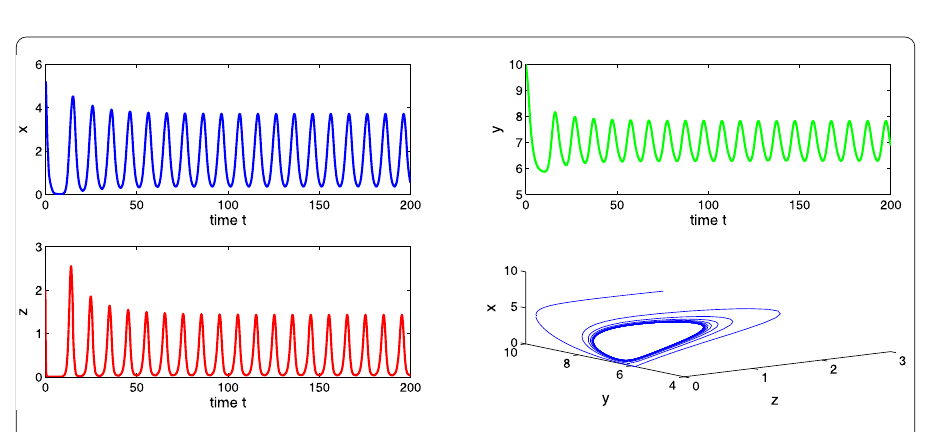
Figure 12 Time evaluation curve and three-dimensional phase portrait of the system for the parameter values a